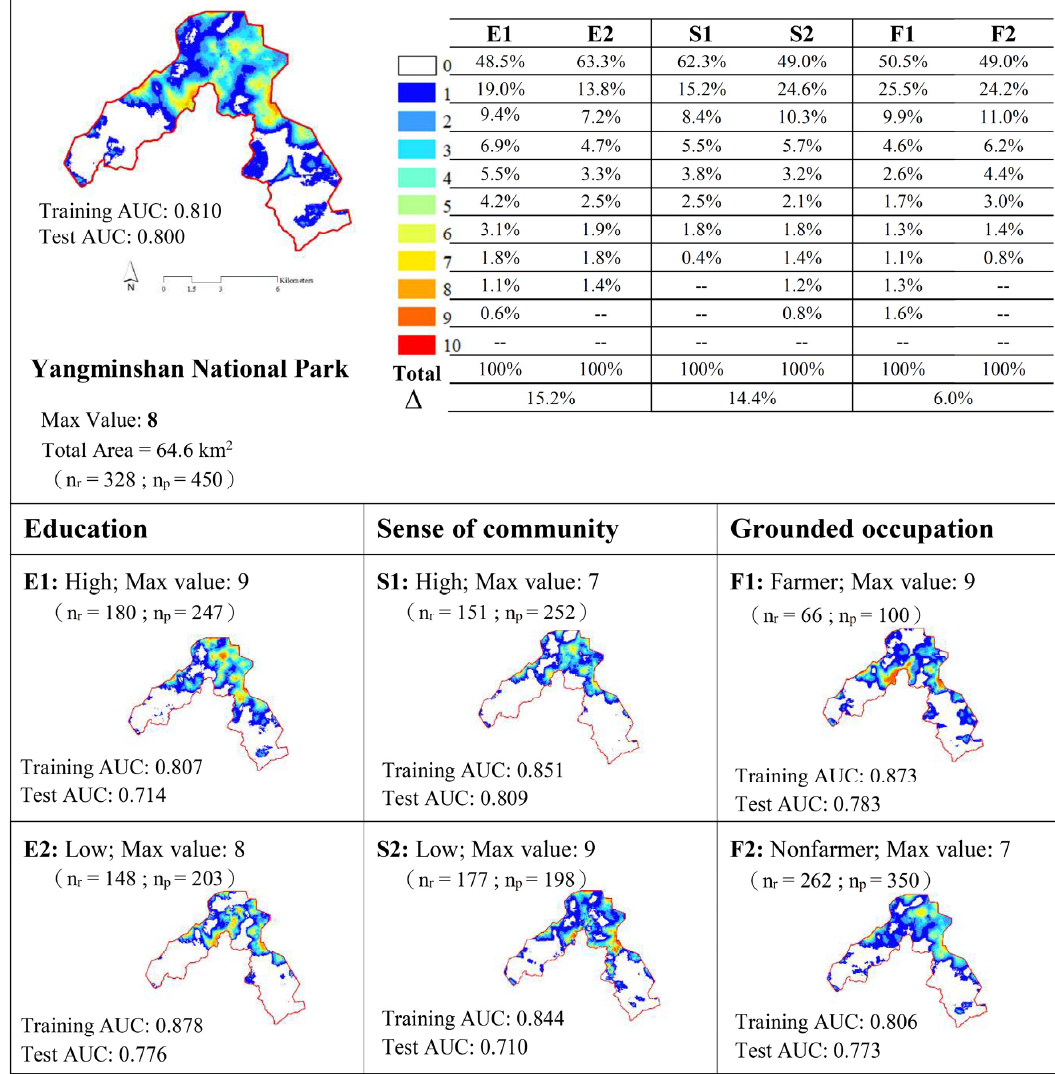
Figure 3. Conservation values between pair assumptions. Note: AUC: area under the curve; %: percentage of total area; Δ : index of dissimilarity; n r : number of respondents; n p : number of identified points; E1: high educational attainment; E2: low educational attainment; S1: high sense of community; S2: low sense of community; F1: farmer; and F2: nonfarmer.